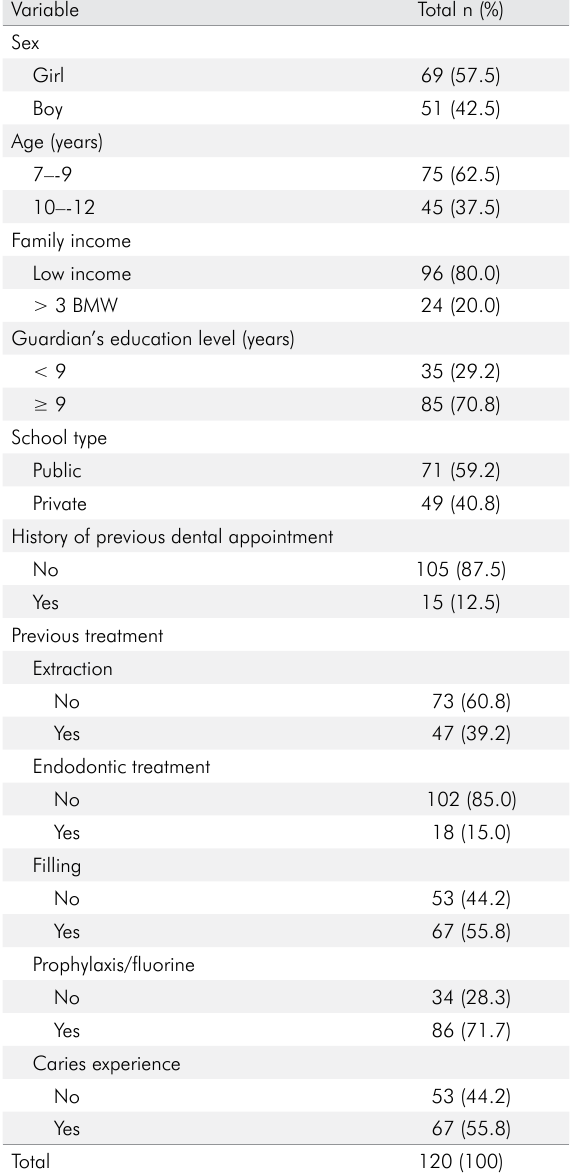
Table 1. Distribution of participants between the